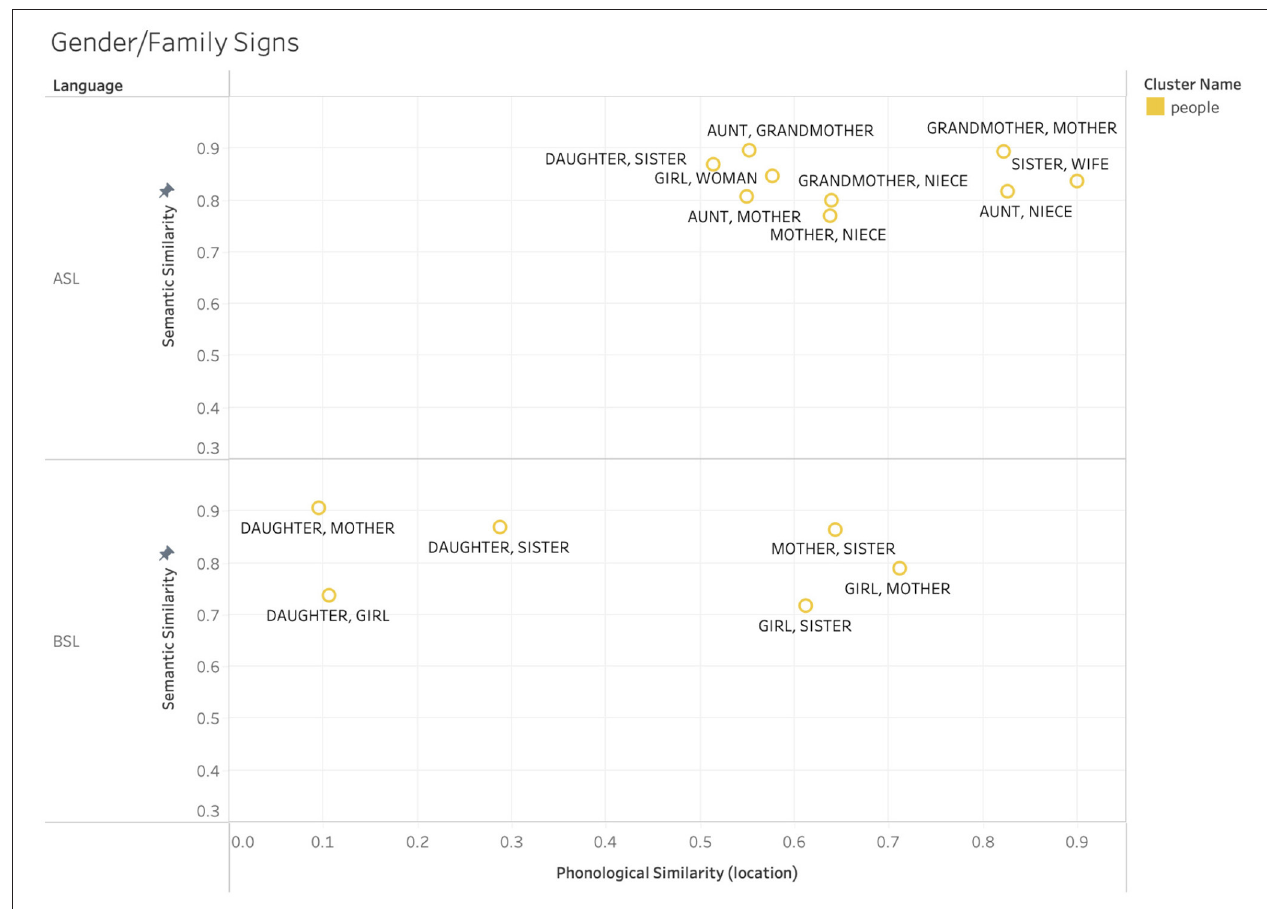
FIGURE 9 | Example sign pairs relating to gender and family roles in ASL and